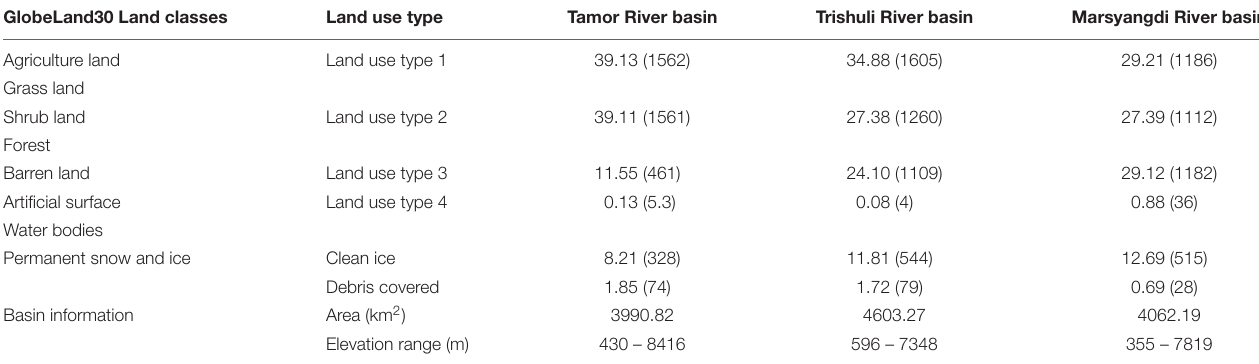
TABLE 2 | Re-classification of land cover classes from GlobeLand30 dataset in Tamor, Trishuli, and Marsyangdi River basins. GlobeLand30 Land classes